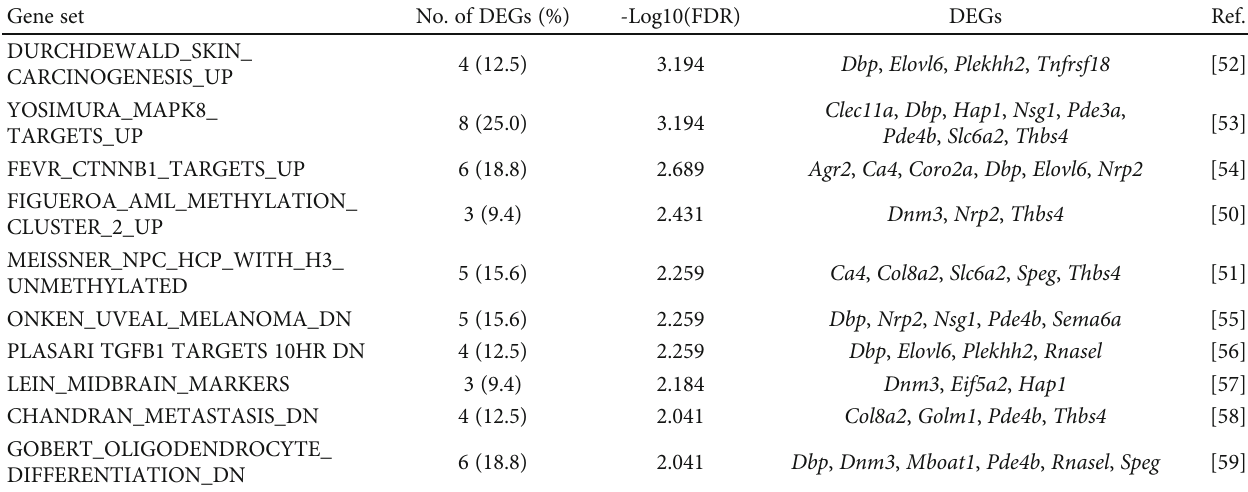
Table 4: Top 10 gene sets derived from the 32 unique DEGs in CPR ∗